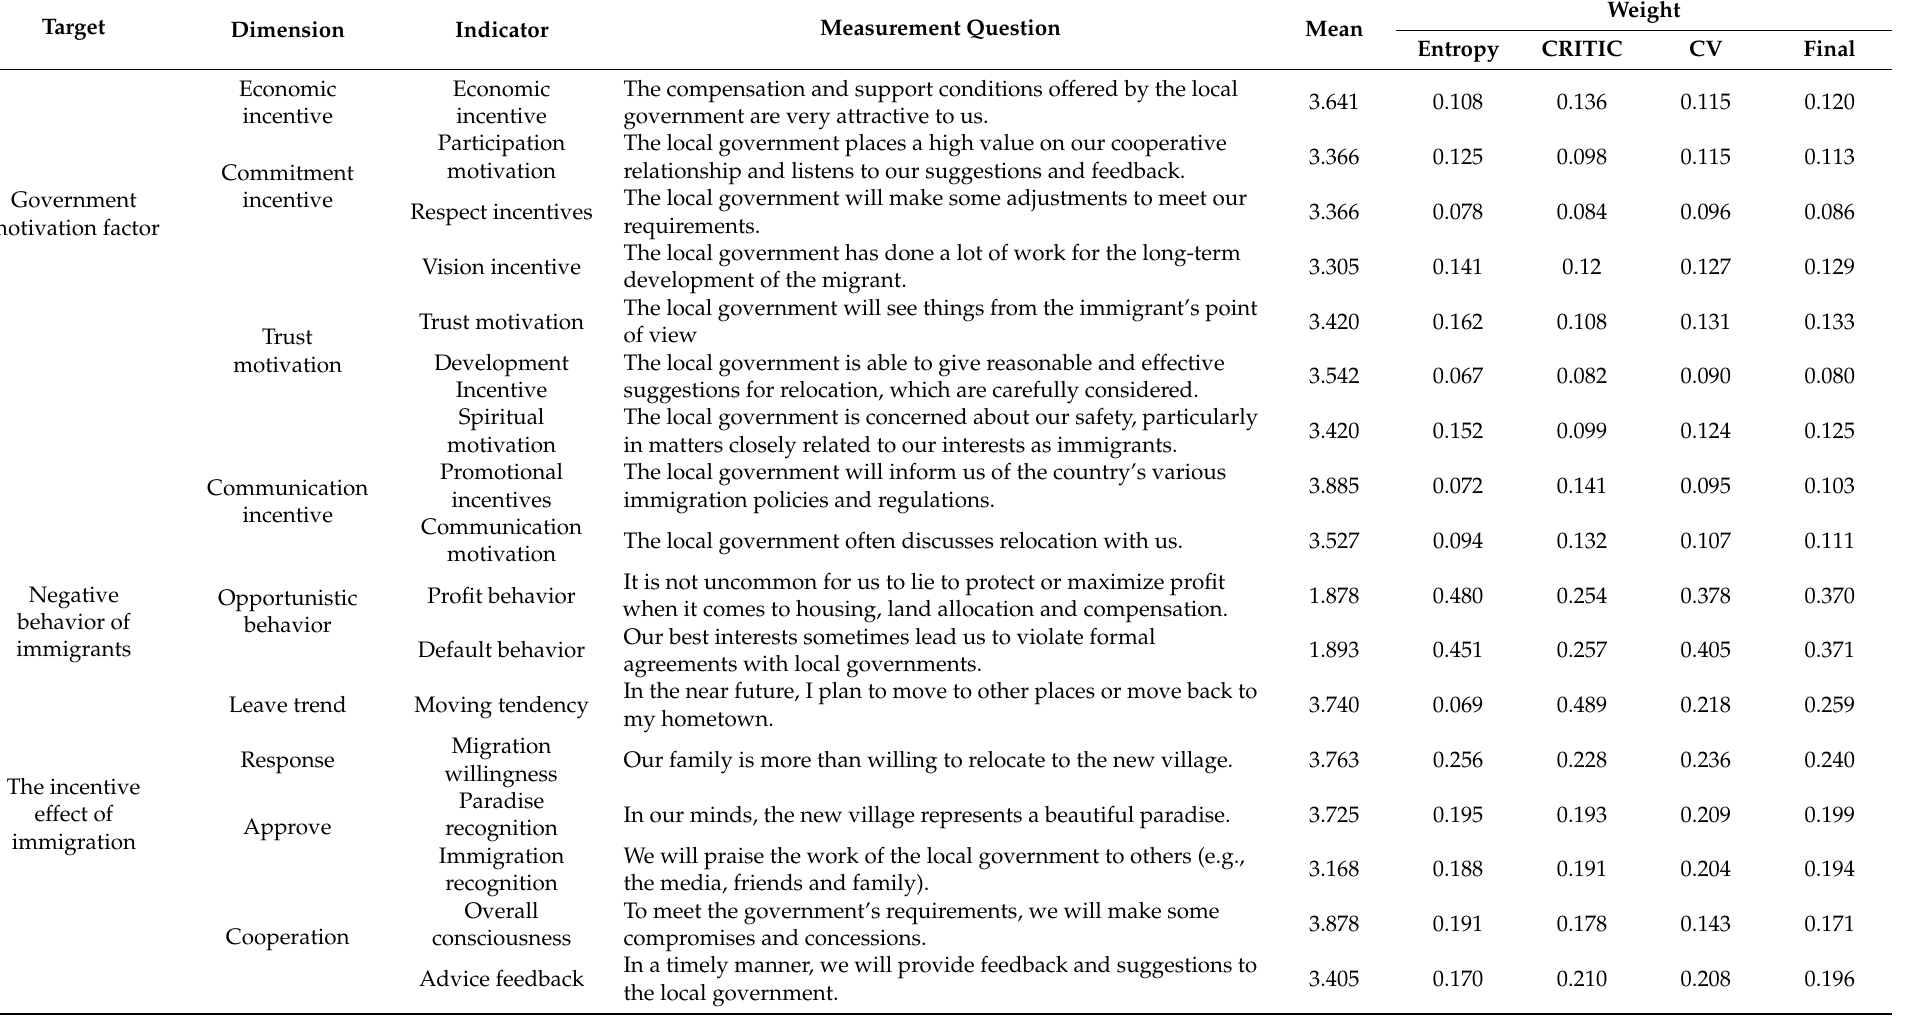
Table 1. Evaluation index system of motivation mechanism of